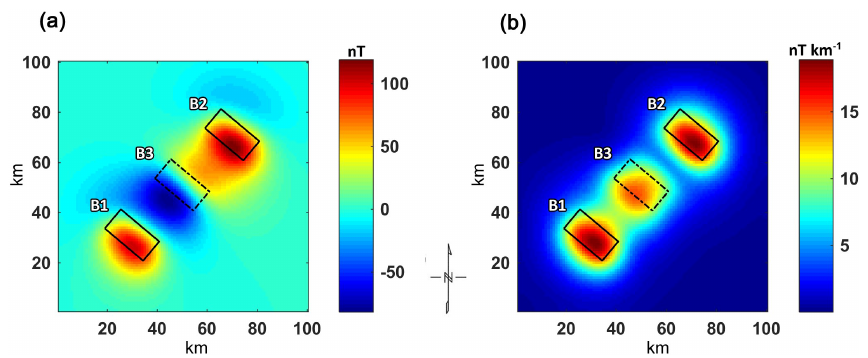
Figure 5. Multisource model with B1 and B2 normally magnetized and B3 reversely magnetized. (a) T map; (b) |∇ T | map.